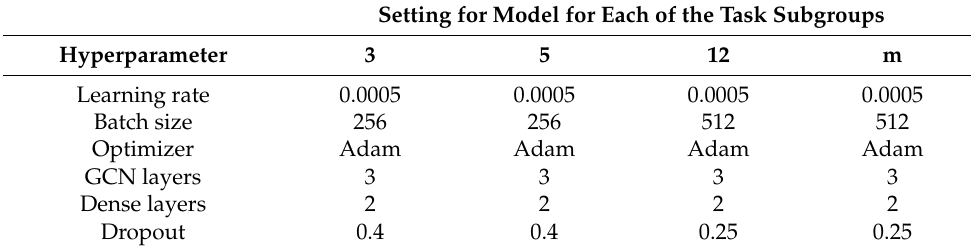
Table 2. Hyperparameters for models used in our experiments. Setting for Model for Each of the Task